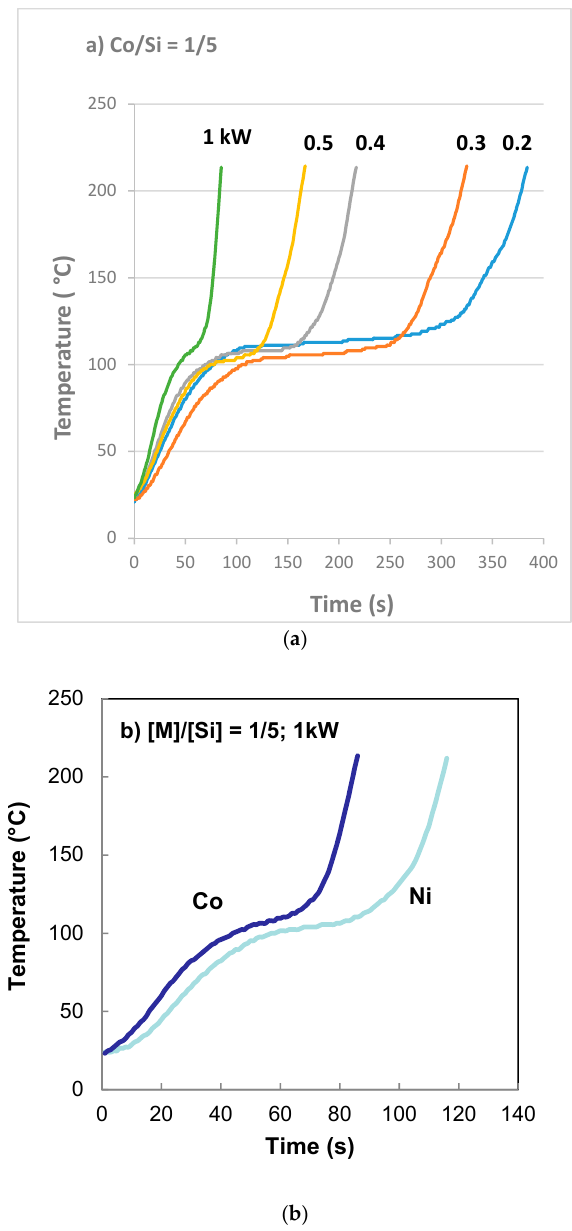
Figure 9. Processing history of silica supported cobalt and nickel catalysts from nitrate solution and coated silica dispersion using microwave radiation at various power ratings when [Co]/[Si] = [Ni]/[Si] = 1/5. ( a ) The effect of microwave power on cobalt nitrate decomposition in the presence of coated silica; ( b ) Comparison of cobalt and nickel on the decomposition rate of